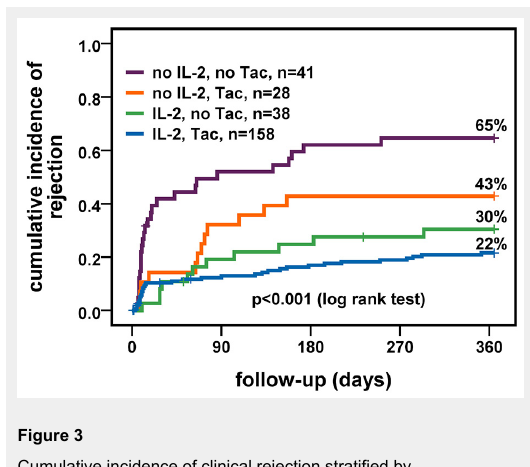
Figure 3 Cumulative incidence of clinical rejection stratified by immunosuppression and induction therapy. IL-2 = interleukin-2 receptor antagonist; Tac =